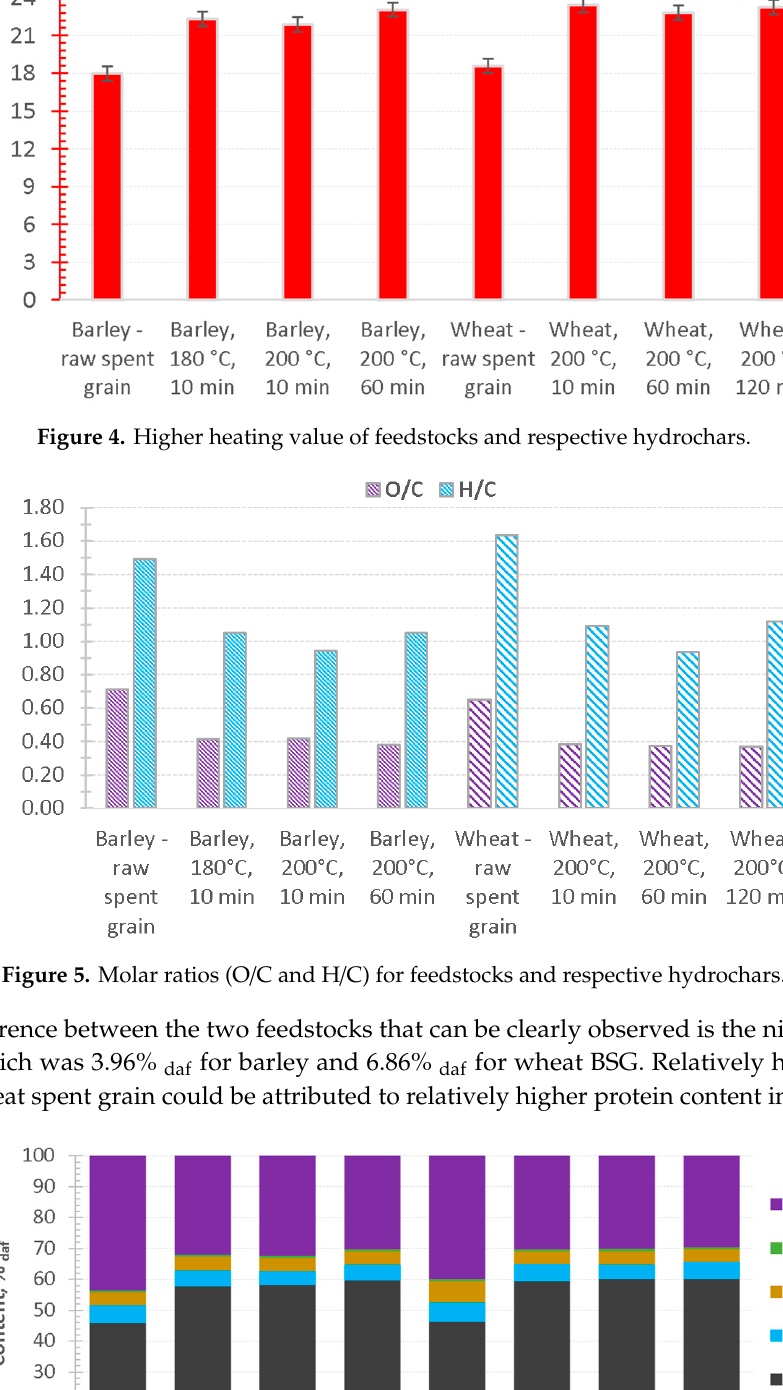
Figure 6. Ultimate analysis results for feedstocks and respective hydrochars.